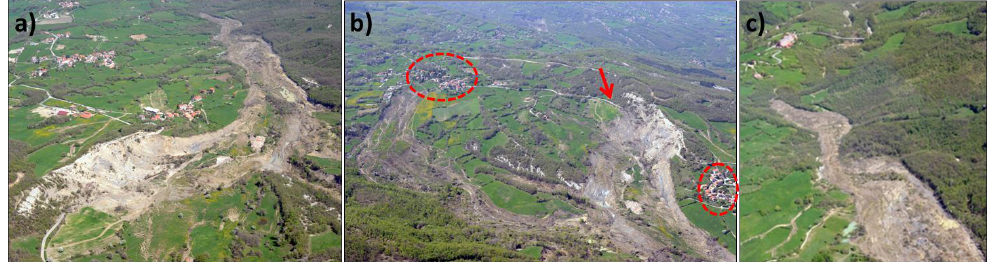
Figure 14. Aerial picture of the Capriglio earthflow ( a ); landslide upper sector ( b ) showing the villages of Capriglio (dashed oval on the left) and Pianestolla (dashed oval on right), were a transect of the local roadway was destroyed (highlighted by the red arrow); the landslide toe ( c ).